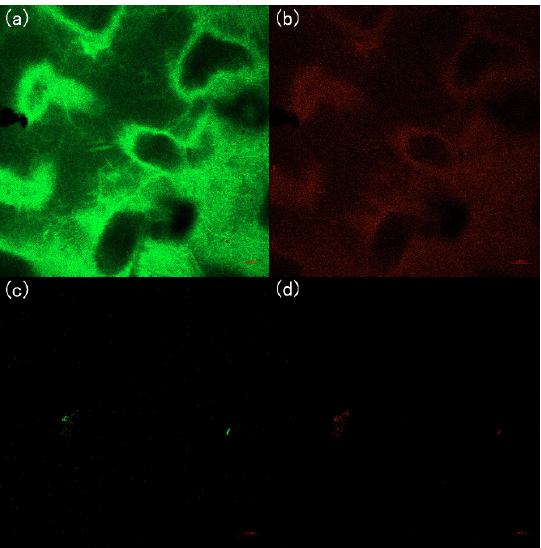
Figure 13. CLSM images of the membranes after the three cycles ultrafiltration experiment. ( a ) Live bacteria on the origin membrane; ( b ) dead bacteria on the origin membrane; ( c ) live bacteria on the P-GO-DAA membrane; ( d ) dead bacteria on the P-GO-DAA membrane.